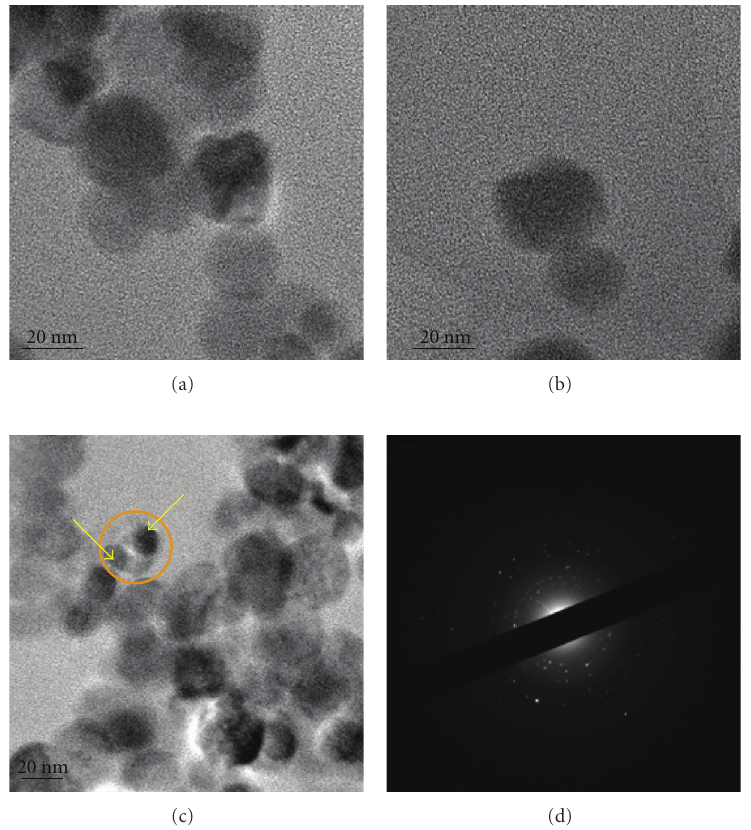
Figure 5: Micrographs of triestearin-5 % magnetite produced by the modified-PGSS technique : (a), (b), (c) TEM images. Two MNPs enclosed in a lipid particle are evidenced by the yellow arrows; (d) spot of di ff raction of electron beam on magnetite nanoparticles.